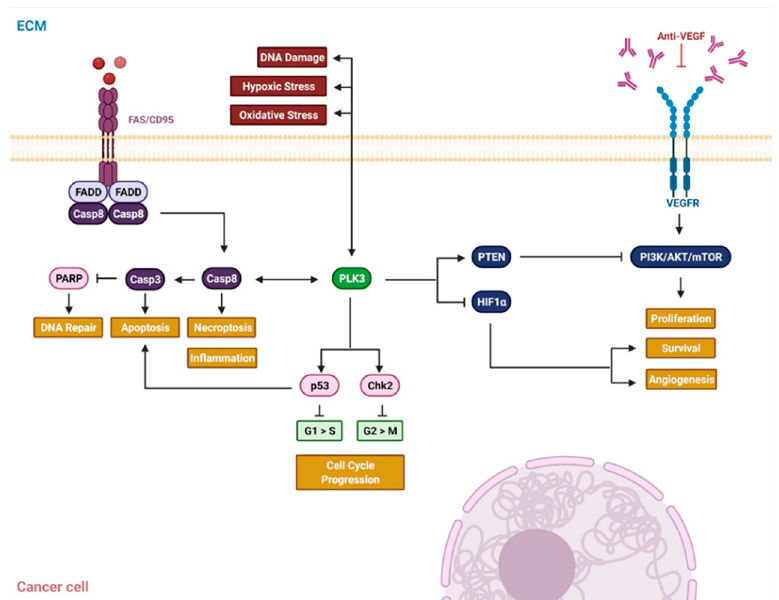
Figure 3. Exemplary illustration of dysregulated signaling pathways and their interactions in cervical cancer. The schematic shows the nexus of dysregulated, activated or discontinued signaling pathways related to PLK3. Upon activation by DNA damage, hypoxic or oxidative stress PLK3 is activated and impacts on apoptosis, cell cycle progression, proliferation and survival. Details are given